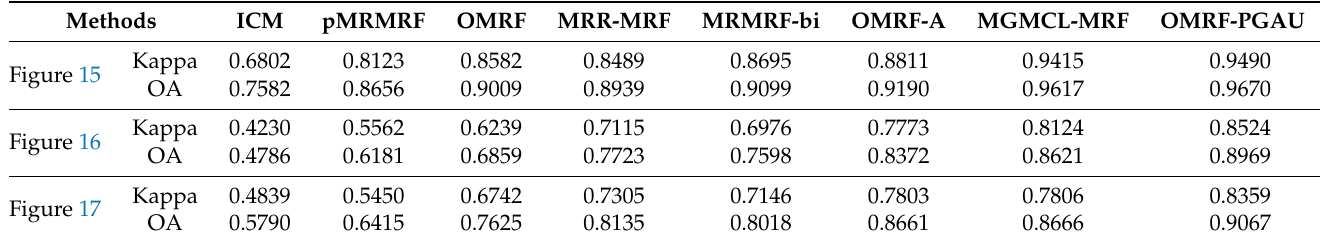
Table 4. Quantitative indicators of eight comparison methods for three aerial images.